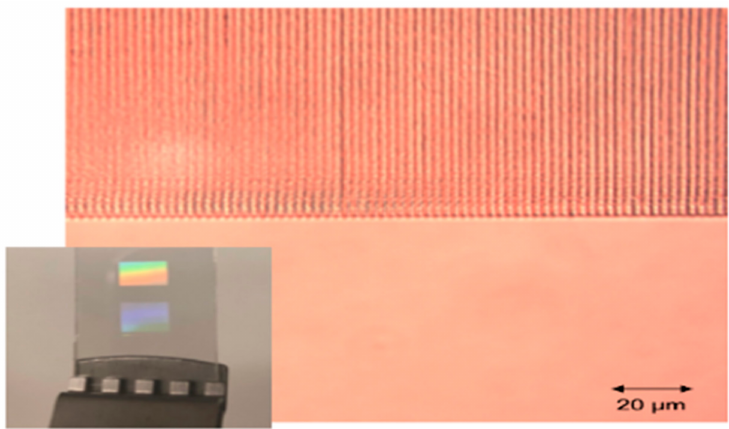
Figure 13. Femtosecond laser-induced Bragg structures in lithium niobate. Reprinted with permission from